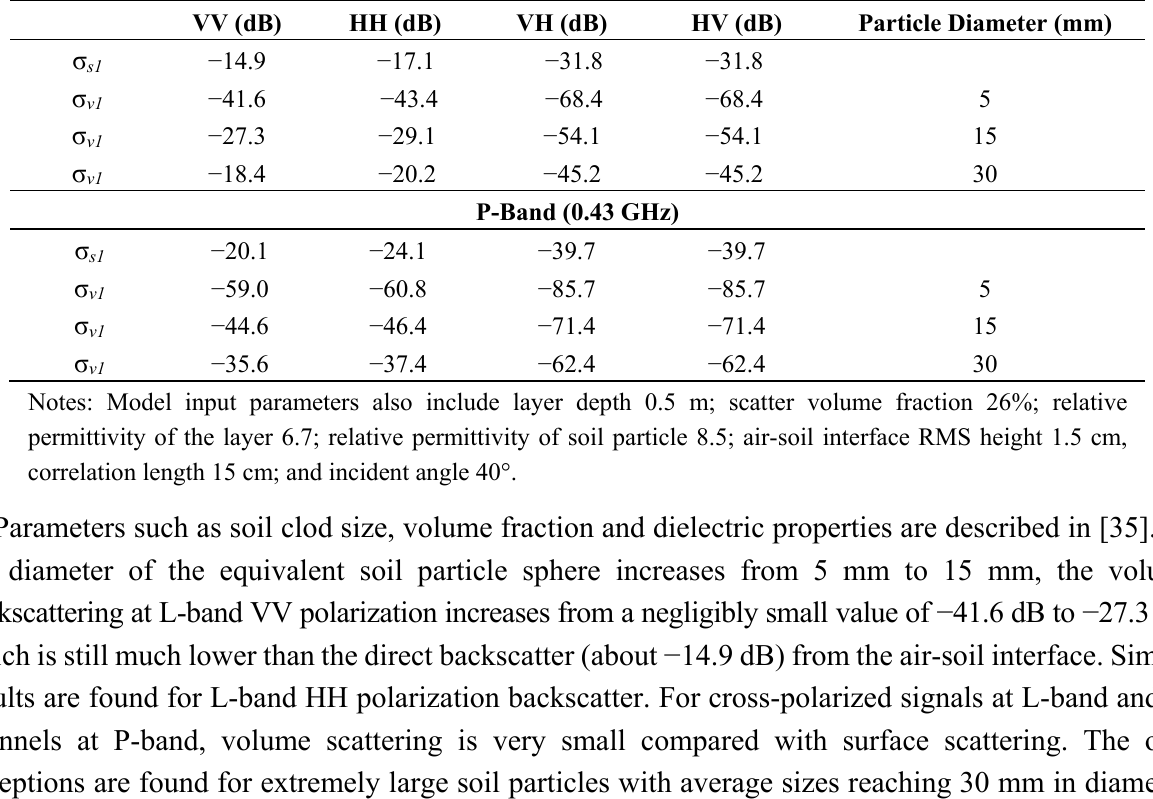
Table 3. Model input parameters and simulation results for studying soil volume scattering effects. L-Band (1.26